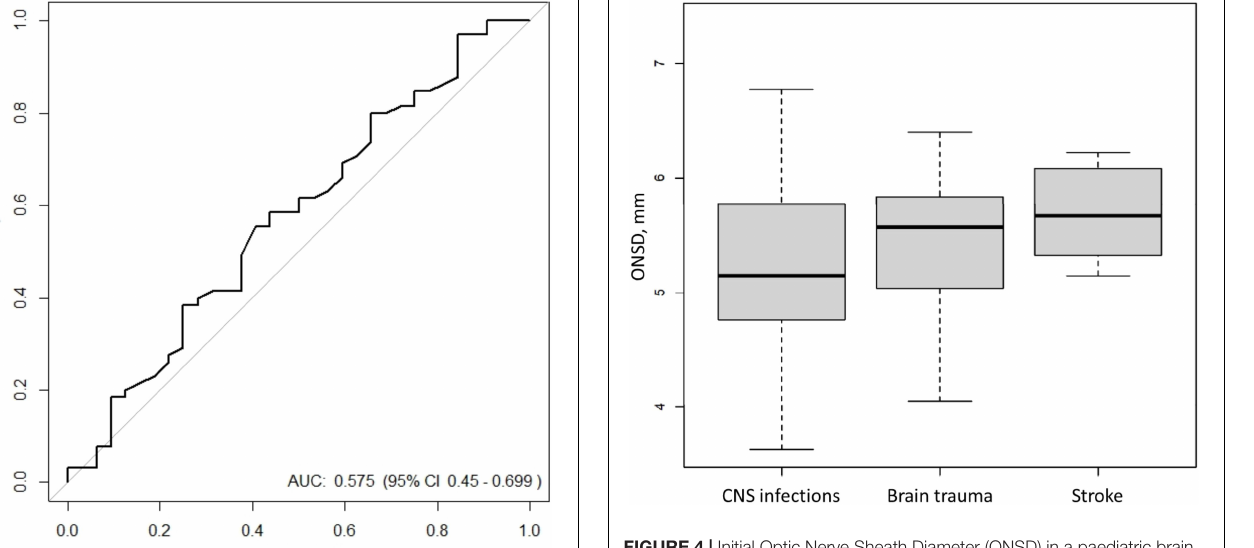
FIGURE 4 | Initial Optic Nerve Sheath Diameter (ONSD) in a paediatric brain injury population according to the aetiology. CNS, central nervous system. Box and whisker plots represent interquartile range and 95% CI, respectively, and the horizontal bar indicates the median.